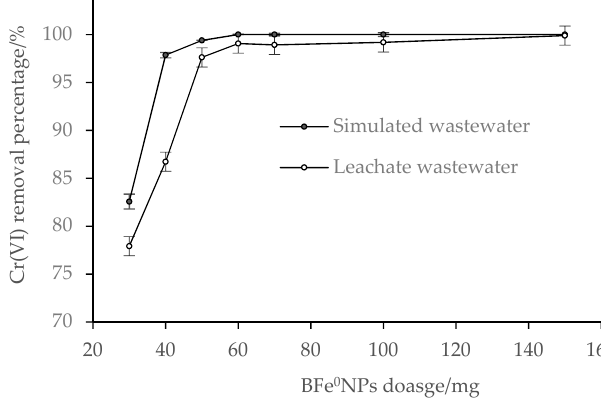
Figure 5. Effect of BFe 0 NPs (4%) dosage on Cr (VI) removal ( n = 3) from wastewaters.